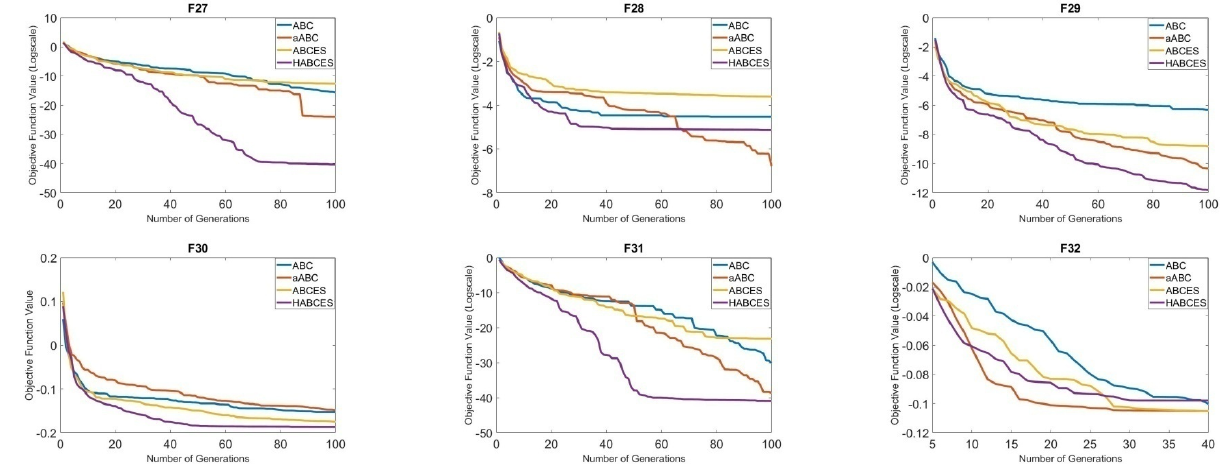
Figure 3. Comparison of the convergences of the ABC, aABC, ABCES and HABCES algorithms when solving low-dimensional global optimization problems (F21–F32).